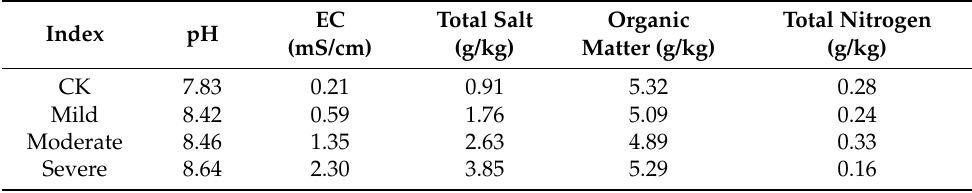
Table 1. Survey of soil parameters under different salt